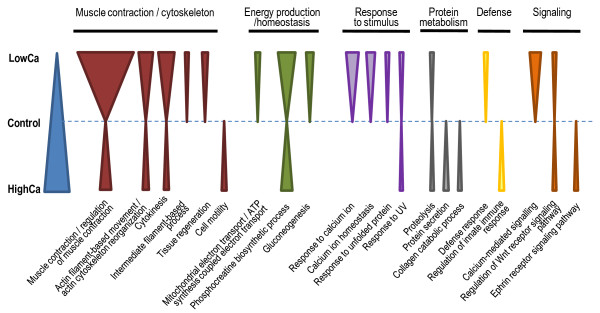
Main biological processes affected by transfer to water at different Ca2+ concentrations in Tetraodon gills. Each triangle represent the differential expression of genes contained in the most represented biological processes (represented in the lower panel and grouped into broad categories in the upper panel) between LowCa (0.01 mM Ca2+) or HighCa (10 mM Ca2+) water and control water (2.9 mM Ca2+, blue triangle). Triangle width is inversely proportional to the adjusted p values obtained for biological process GO categories in our GO enrichment/clustering analysis (wider for most enriched processes); shown categories were selected among the most enriched GOs (adjusted p values > 10-4).